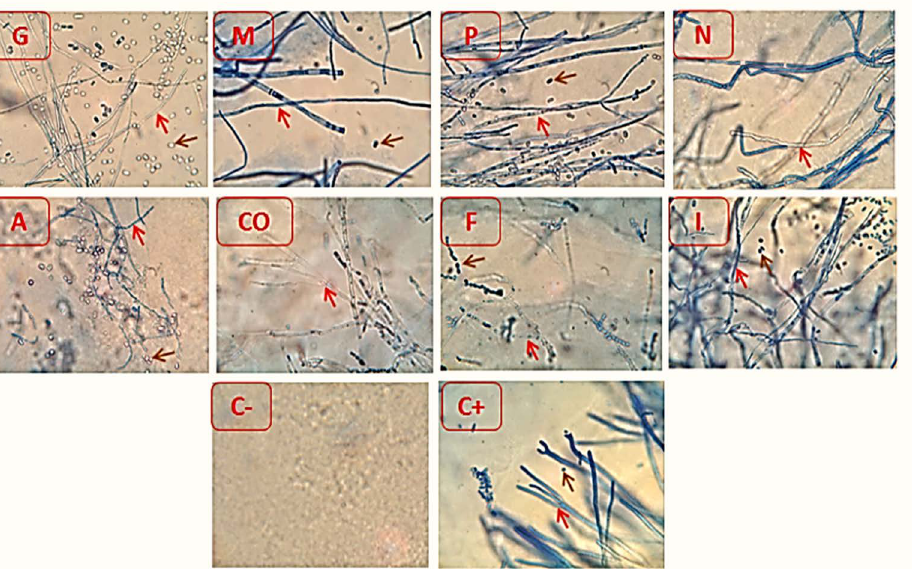
Fig. 4. Microscopic appearance of B. sanguinis growing tops on PDA media after mixed with different antiseptics, G = PDA media mixed with Malachite green at concentration 5mg/l, M= PDA media mixed Methylene blue at concentration 10mg/l, P= PDA media mixed Potassium permanganate at concentration 20 ppm, A= PDA media mixedwith Quaternary ammonium, N= PDA media mixed with NaCl at concentration 5%, CO= PDA media mixed Copper sulfate at concentration 0.5mg/l , F= PDA media mixed Formalin at concentration 250 ppm and I= PDA media mixed Povidone iodine at concentration 100mg/ml. C+=control positive, C- = Control